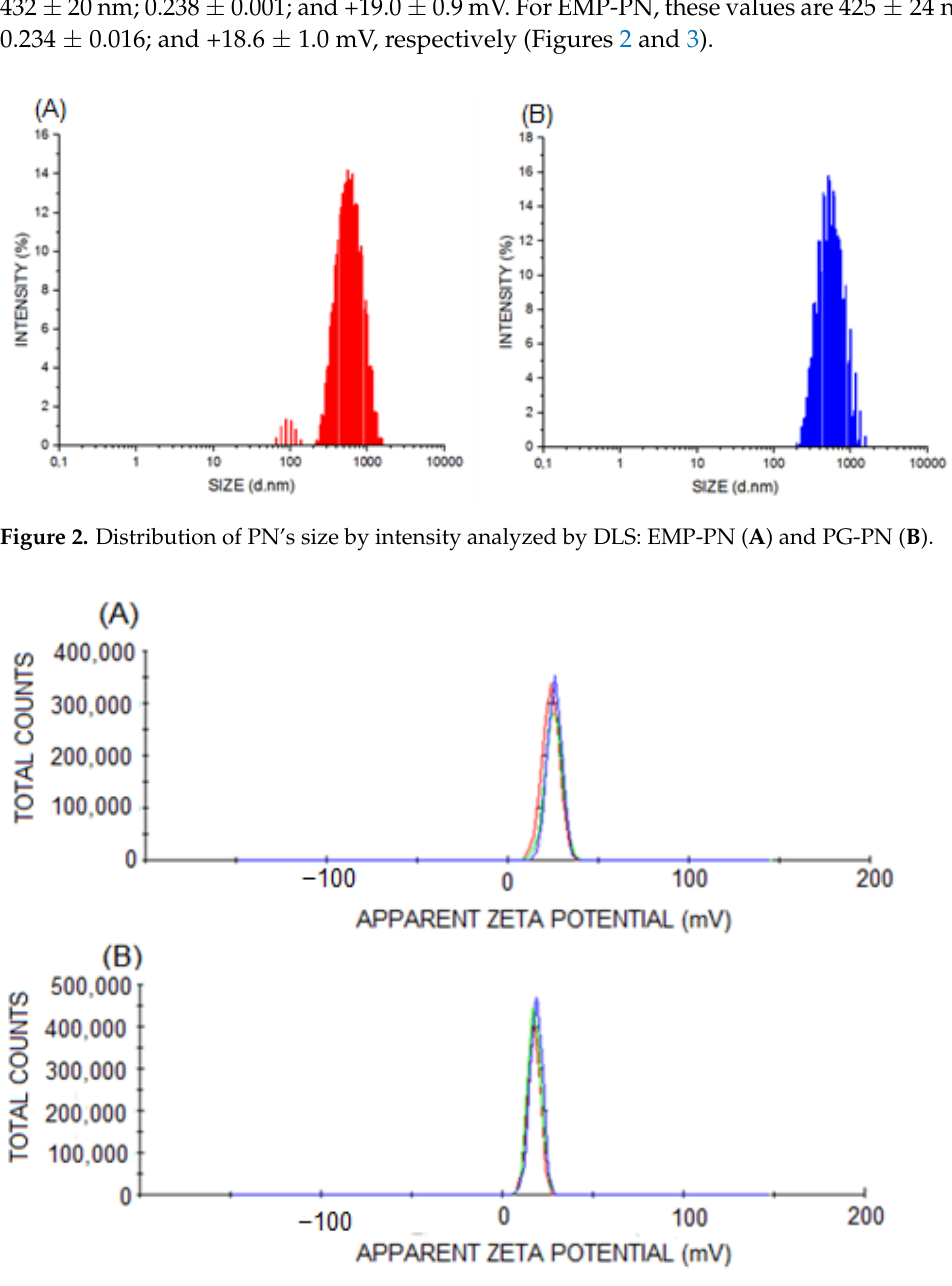
Figure 3. Distribution of PN’s zeta potential: EMP-PN ( A ) and PG-PN ( B ).